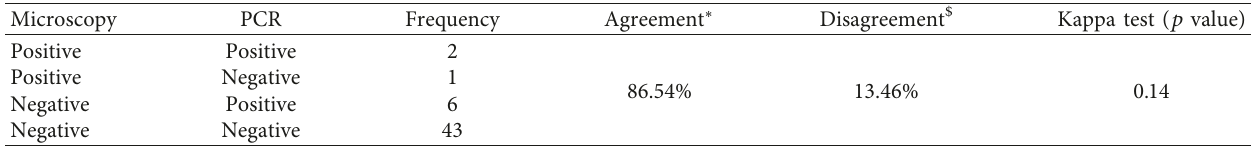
Table 4: Comparison of diagnostic results for H. pylori ( n � 52).